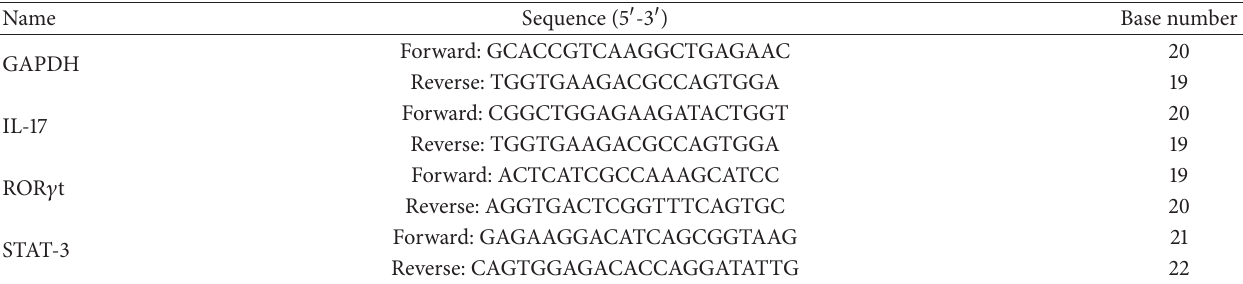
Table 2: Primers and